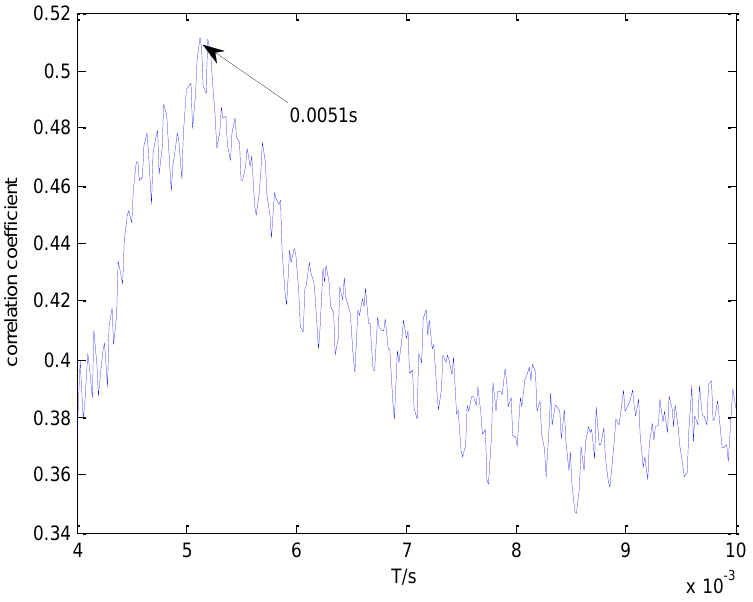
Figure 19. Maximal correlation coefficients for different elements from set T , using the proposed method on the inner race fault signal.